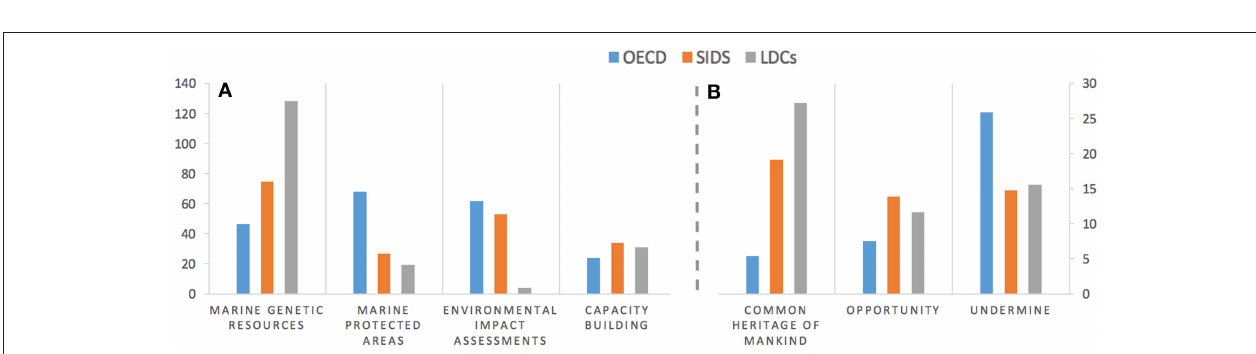
FIGURE 3 | Number of authors (green bars) of peer-reviewed articles on biodiversity in areas beyond national jurisdiction (BBNJ), and number of countries home to this number of authors (blue bars). Inset shows the logarithmic correlation between the number of authors with affiliations in each country and the percentage of countries with that number of authors. One hundred and sixty three countries were not represented by any authors in the BBNJ literature.